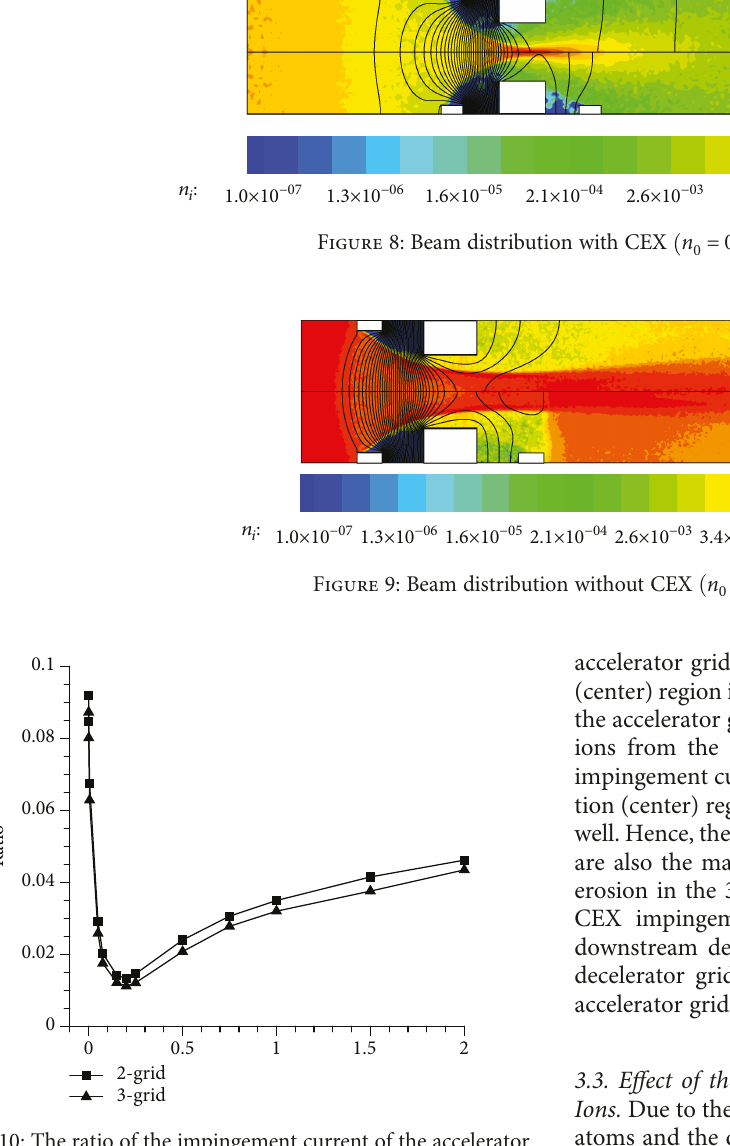
Figure 10: The ratio of the impingement current of the accelerator grid to the beam